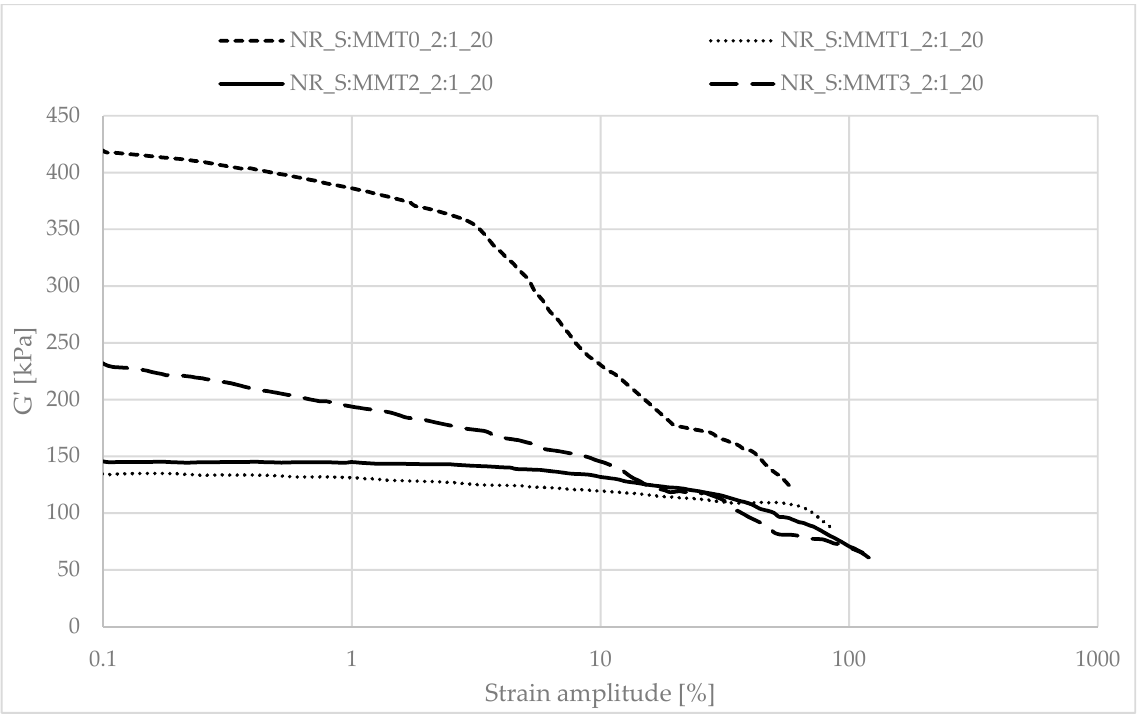
Figure 9. Dependence of the storage module as a function of the strain amplitude for natural rubber composites filled with straw:montmorillonite filler (20 phr), 2:1 ratio.